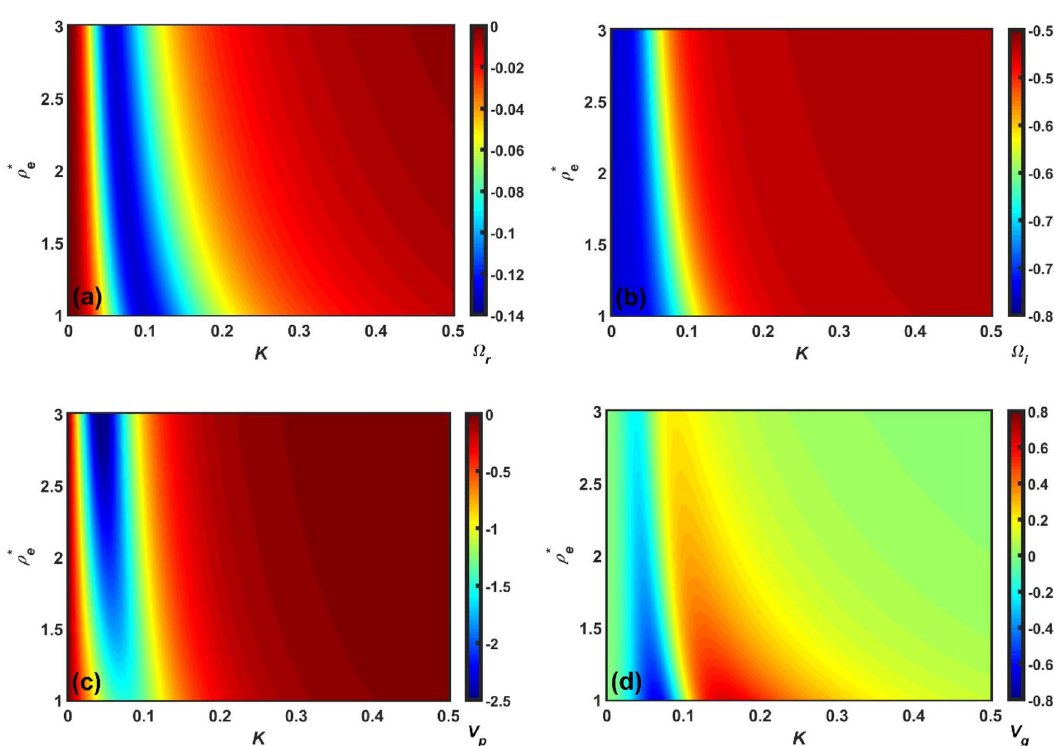
Figure 7. Same as Fig. 5, but showing the ρ ∗ e -variation with a fixed ρ ∗ h